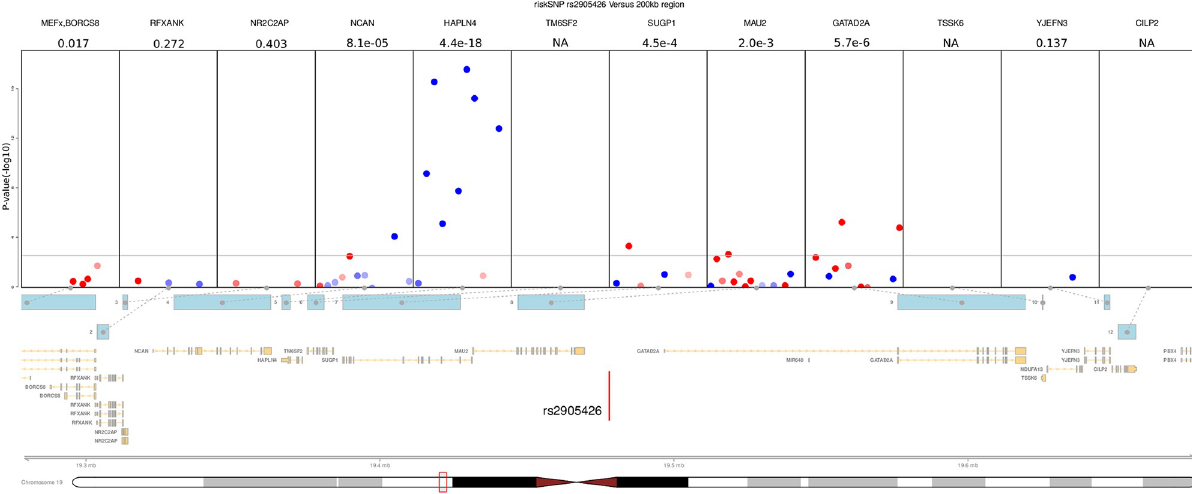
Fig 3. Plot of aeQTL effects in the genes surrounding the rs2905426 risk-SNP. Each box in the annotationTrack shows one gene. Each dot shows one analyzable txSNP. The X-position of the dot indicates location in gene, and the Y-position indicates the aeQTL significance levels as–log10(P). The horizontal line indicates txSNP level significance at FDR5% (P = 0.0030). The color of each dot indicates effect-direction, red corresponds to increased fraction of ref-allele containing reads. The intensity of the color corresponds to the number of samples analyzable for the given txSNP, with 100 or more samples shown as fully saturated color. The GeneRegionTrack indicates the location of all the genes of interest surround this risk-SNP. The risk-SNP is indicated as a vertical red line. The top track contains the name of the gene as well as the P-value of the strongest associated txSNP.